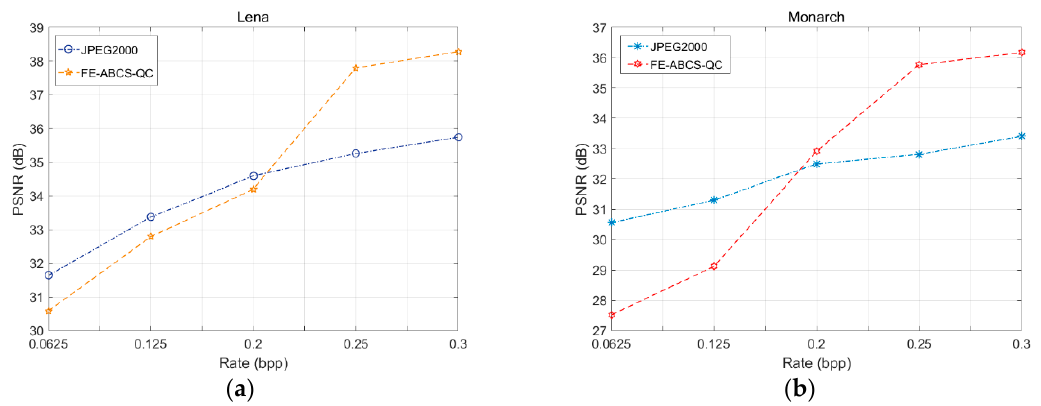
Figure 12. Rate-distortion performance for JPEG2000 and FE-ABCS-QC: ( a ) Lena, ( b ) Monarch.